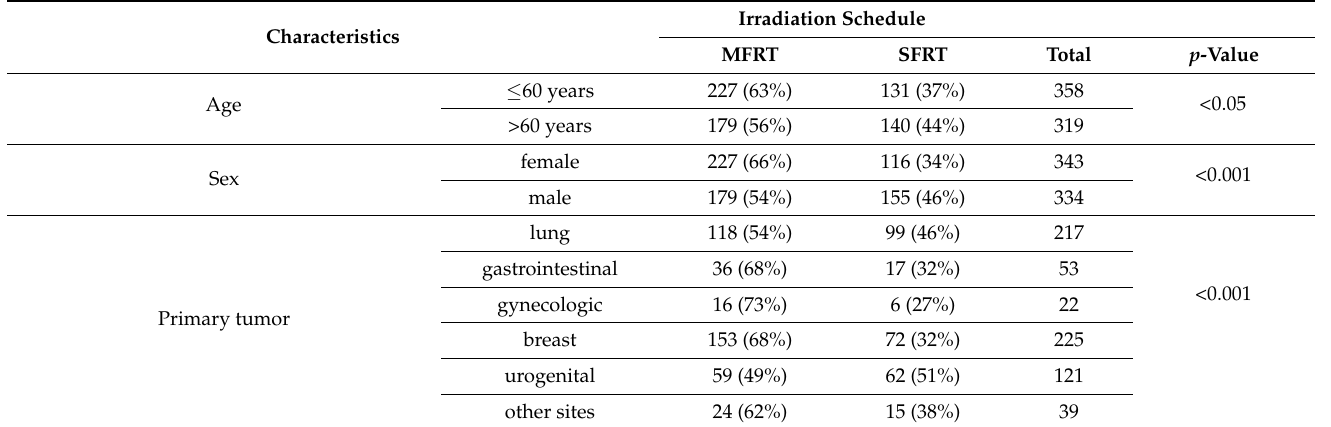
Table 4. The association of prescription of radiotherapy regimens based on patient characteristics.